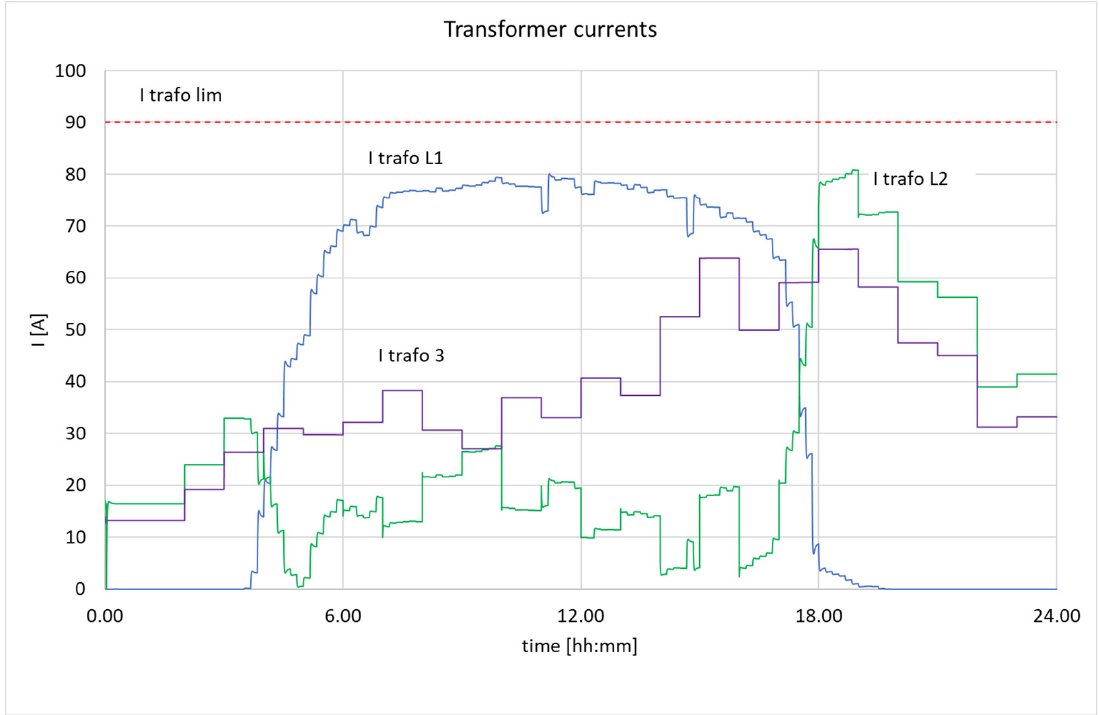
Figure 7. MV/LV transformer currents during one-day simulation, reference case.